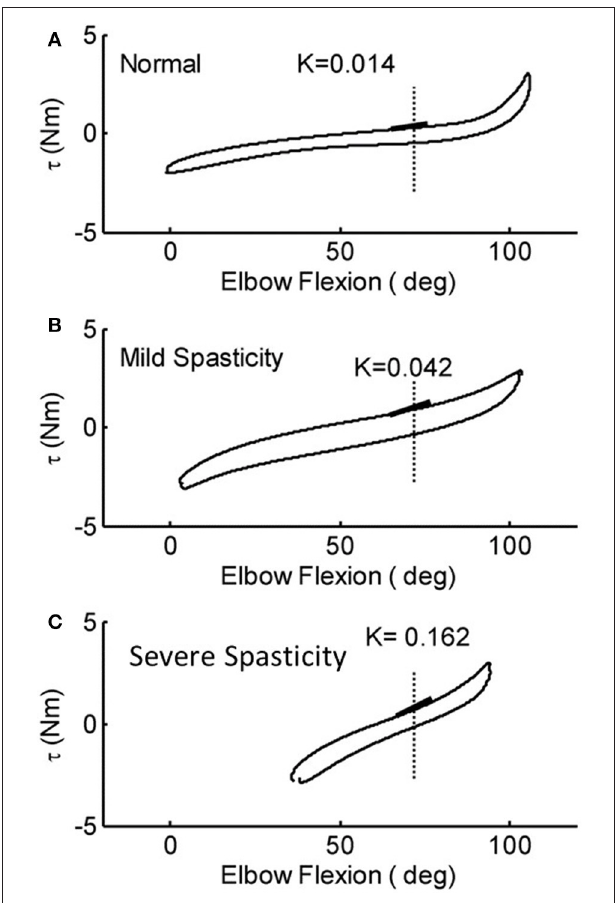
FIGURE 7 | Representative torque-angle curves of stroke survivors [mild (B) and severe (C) ] and a healthy control (A) . Full elbow extension = 0 ◦ . The slope of the thick black lines indicates the elastic stiffness of the elbow recorded at a common